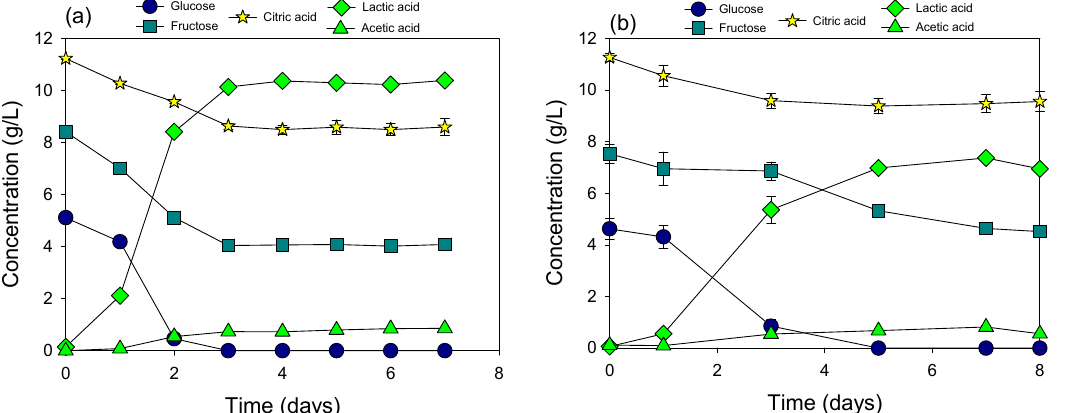
Figure 1. Fermentation of original cucumber extract by Lactobacillus plantarum ( a ) and Pediococcus acidilactici ( b ).